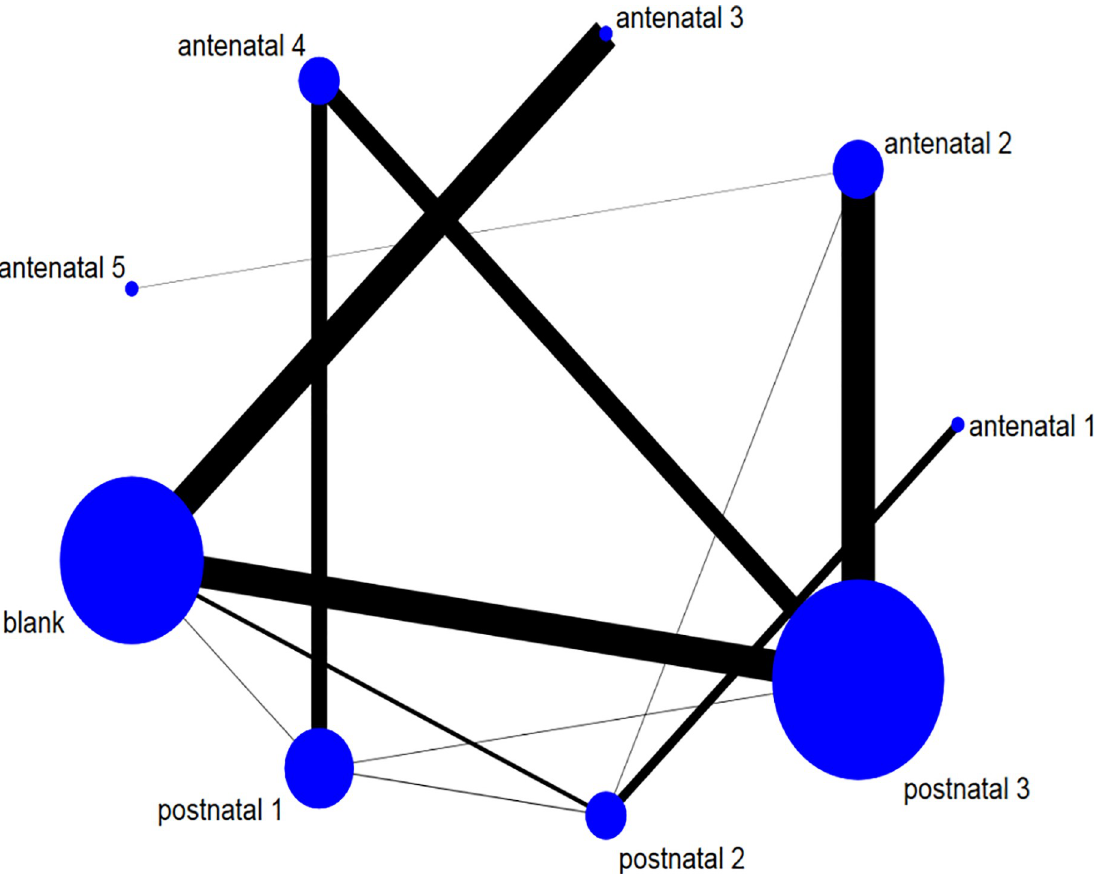
Fig 2. Network relationship of the included treatment measures. vs. blank/F: OR = 0.01, 95% CI = 0.01–0.03; antenatal 1/A vs. blank/F: OR = 0.05, 95% CI = 0.01–0.18; postnatal 3/I vs. blank/F: OR = 0.04, 95% CI = 0.02–0.06, P < 0.05; postnatal 2/ H vs. blank/F: OR = 0.11, 95% CI = 0.04–0.31; antenatal 3/C vs. blank/F: OR = 0.15, 95% CI = 0.09–0.24; all P < 0.05). This indicated that injections of anti-D immunoglobulin, whether before or after delivery, significantly reduced the incidence of maternal serum that was positive for anti-D antibody in Rh-negative mothers with Rh-positive fetuses. Moreover, antenatal 5/E, antenatal 2/B, antenatal 4/D, antenatal 1/A and postnatal 3/I were the most effective treatment measures for reducing the incidence of maternal anti-D antibody positivity (antenatal 5/E vs. antenatal 2/B: OR = 0.12, 95% CI = 0.00–6.05; antenatal 2/B vs. antenatal 4/D: OR = 0.41, 95% CI = 0.20–0.82, P < 0.05; antenatal 4/D vs. postnatal 3/I: OR = 0.39, 95% CI = 0.22–0.67, P < 0.05; postnatal 3/I vs. antenatal 1/A: OR = 0.78, 95% CI = 0.20–3.08, P > 0.05). Similarly, we used a forest plot to represent the network meta-analysis results (Fig 4). All immunization schemes were significantly more effective than was the blank control scheme ( P < 0.05). Rank probability. Injecting 300 μ g of anti-D immunoglobulin at 28 and 34 gestational weeks (antenatal 5/E) was the most effective treatment (surface under the cumulative ranking curve [SUCRA] = 96.8%; Fig 5), and administering 300 μ g within 28 gestational weeks (ante- natal 2/B) was the second most effective (SUCRA = 89.2%). Administering no injection or a placebo was the least effective (SUCRA = 0.0%).